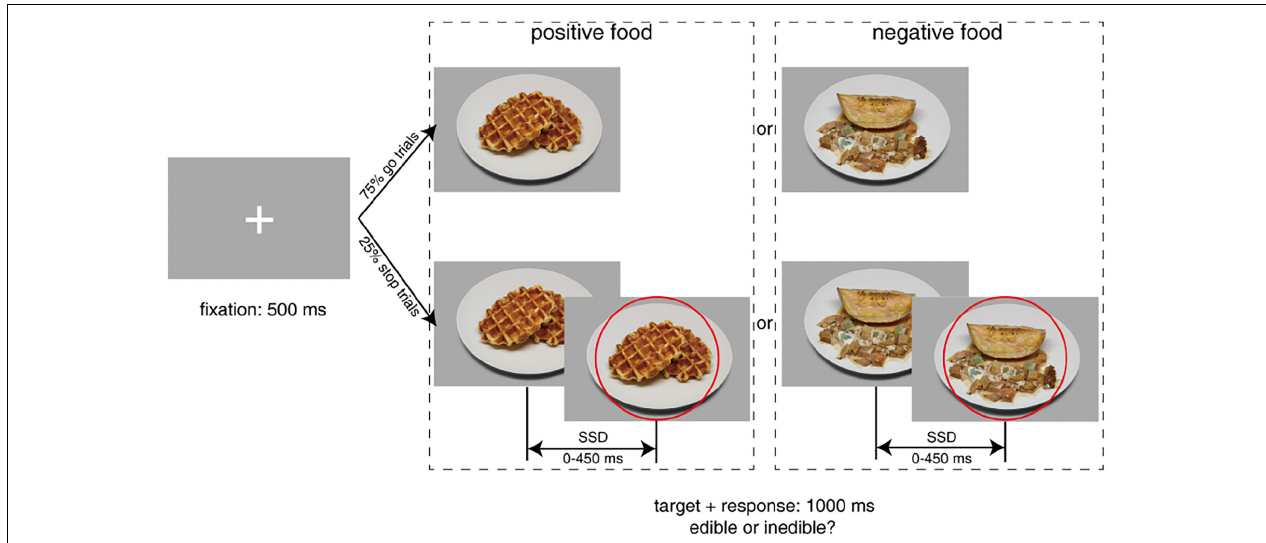
FIGURE 2 | Schematic overview of the explicit emotional stop-signal paradigm. Participants were asked to classify food stimuli as edible or inedible as quickly as possible in go trials. In stop trials, they had to withhold the response when they saw the stop signal (a red circle). Standardized food images were taken from the CROCUFID database available from the OSF repository at https://osf.io/5jtqx. SSD, stop-signal